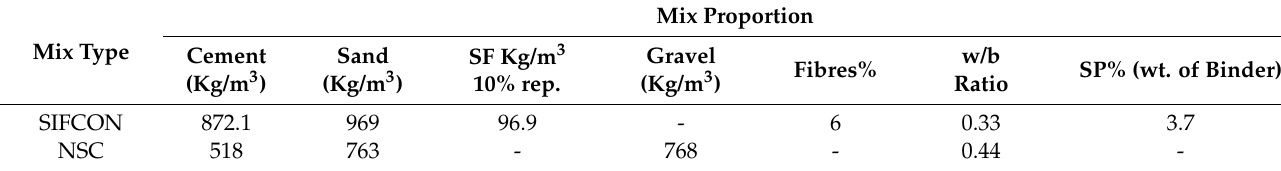
Table 1. Mixing proportion of SIFCON and normal strength concrete.